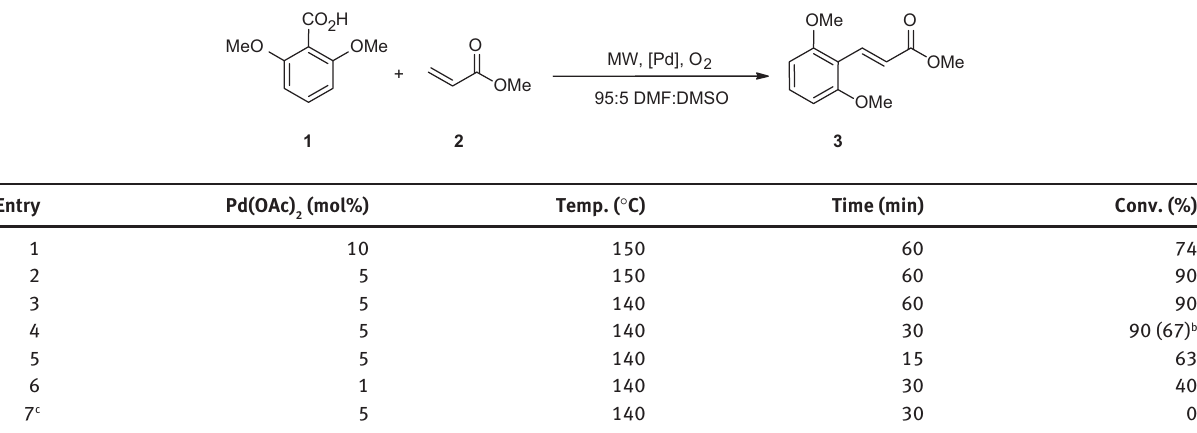
Table 1 Optimization of reaction conditions using microwave heating.